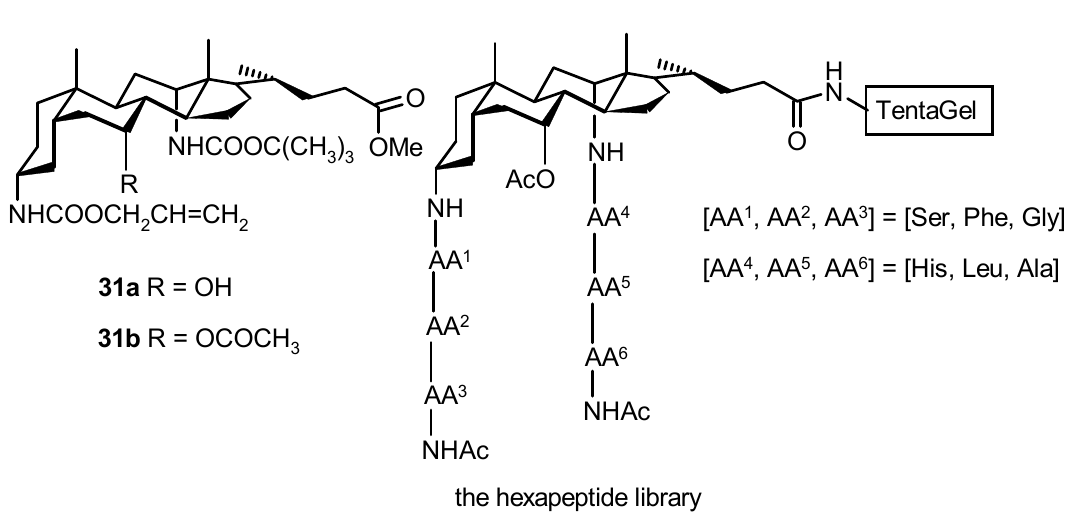
Figure 20. Trifunctional bile acid-based scaffolds 31a - b and the hexapeptide library constructed from the free acid of 31b [133-134]. (Ser = serine, Phe = phenylalanine, Gly = glysine, His = histidine, Leu = leucine, Ala =